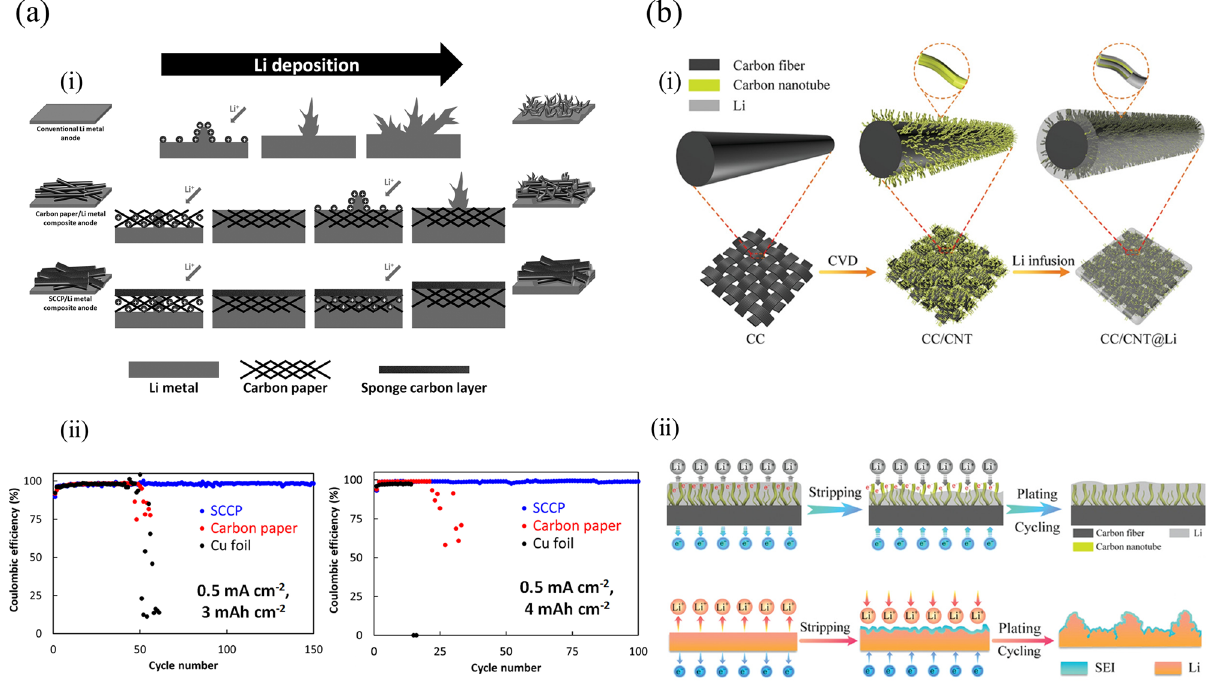
Figure 5: Schematic diagrams of ( a ) Li metal deposition on planar Li, carbon paper/Li, SCCP/Li surface ( i ) and coulombic e ffi ciencies for Li plating of 3 and 4 mA h cm − 2 , at a current density of 0.5 mA cm − 2 ( ii ) , reprinted with permission from [ 59 ] ; ( b ) the synthesis procedures of from [ 60 ]